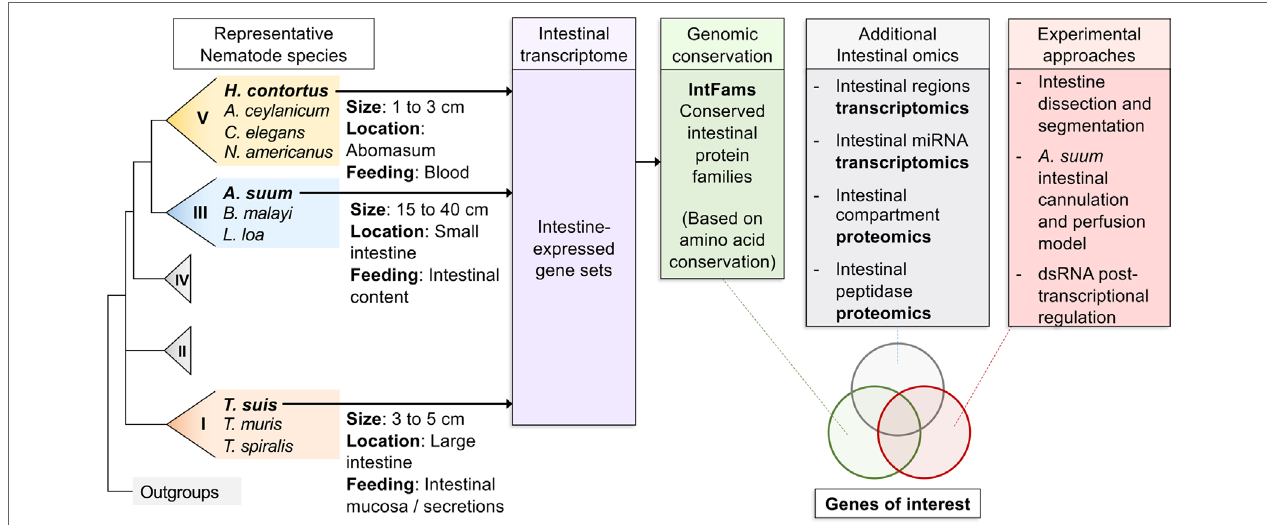
FIGURE 1 | Overall workflow of reviewed intestinal experiments. Transcriptomic and genomic data for core intestinal nematode species are utilized to define intestinal families. Results from additional experiments are intersected and compared to produce prioritized genes of interest to suit experimental